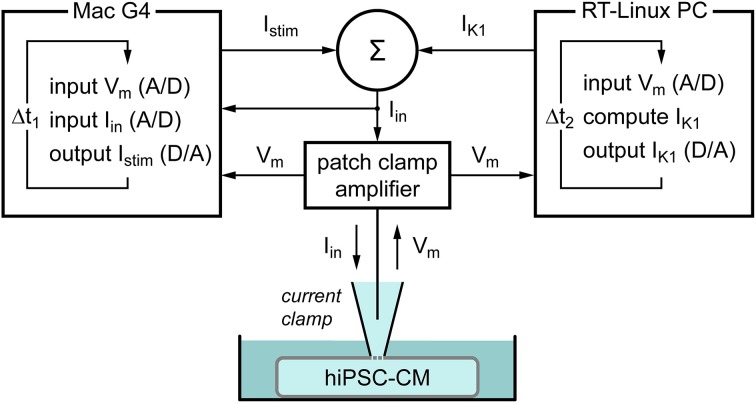
Diagram of the experimental setup. The membrane potential (Vm) of a single human induced pluripotent stem cell derived cardiomyocyte (hiPSC-CM) is recorded using the perforated patch clamp technique in current clamp mode. The injected current (Iin) is the sum of a stimulus current (Istim) and a virtual inward rectifier potassium current (IK1), which is computed in real time, based on the recorded value of Vm (dynamic clamp). The stimulus protocol is run on an Apple Macintosh G4 computer (left), whereas a Real-Time Linux (RT-Linux) based PC is used for the continuous computation of IK1 (right). Sample rates are 4 and 25 kHz, respectively (Δt1 = 0.25 ms and Δt2 = 40 μs).